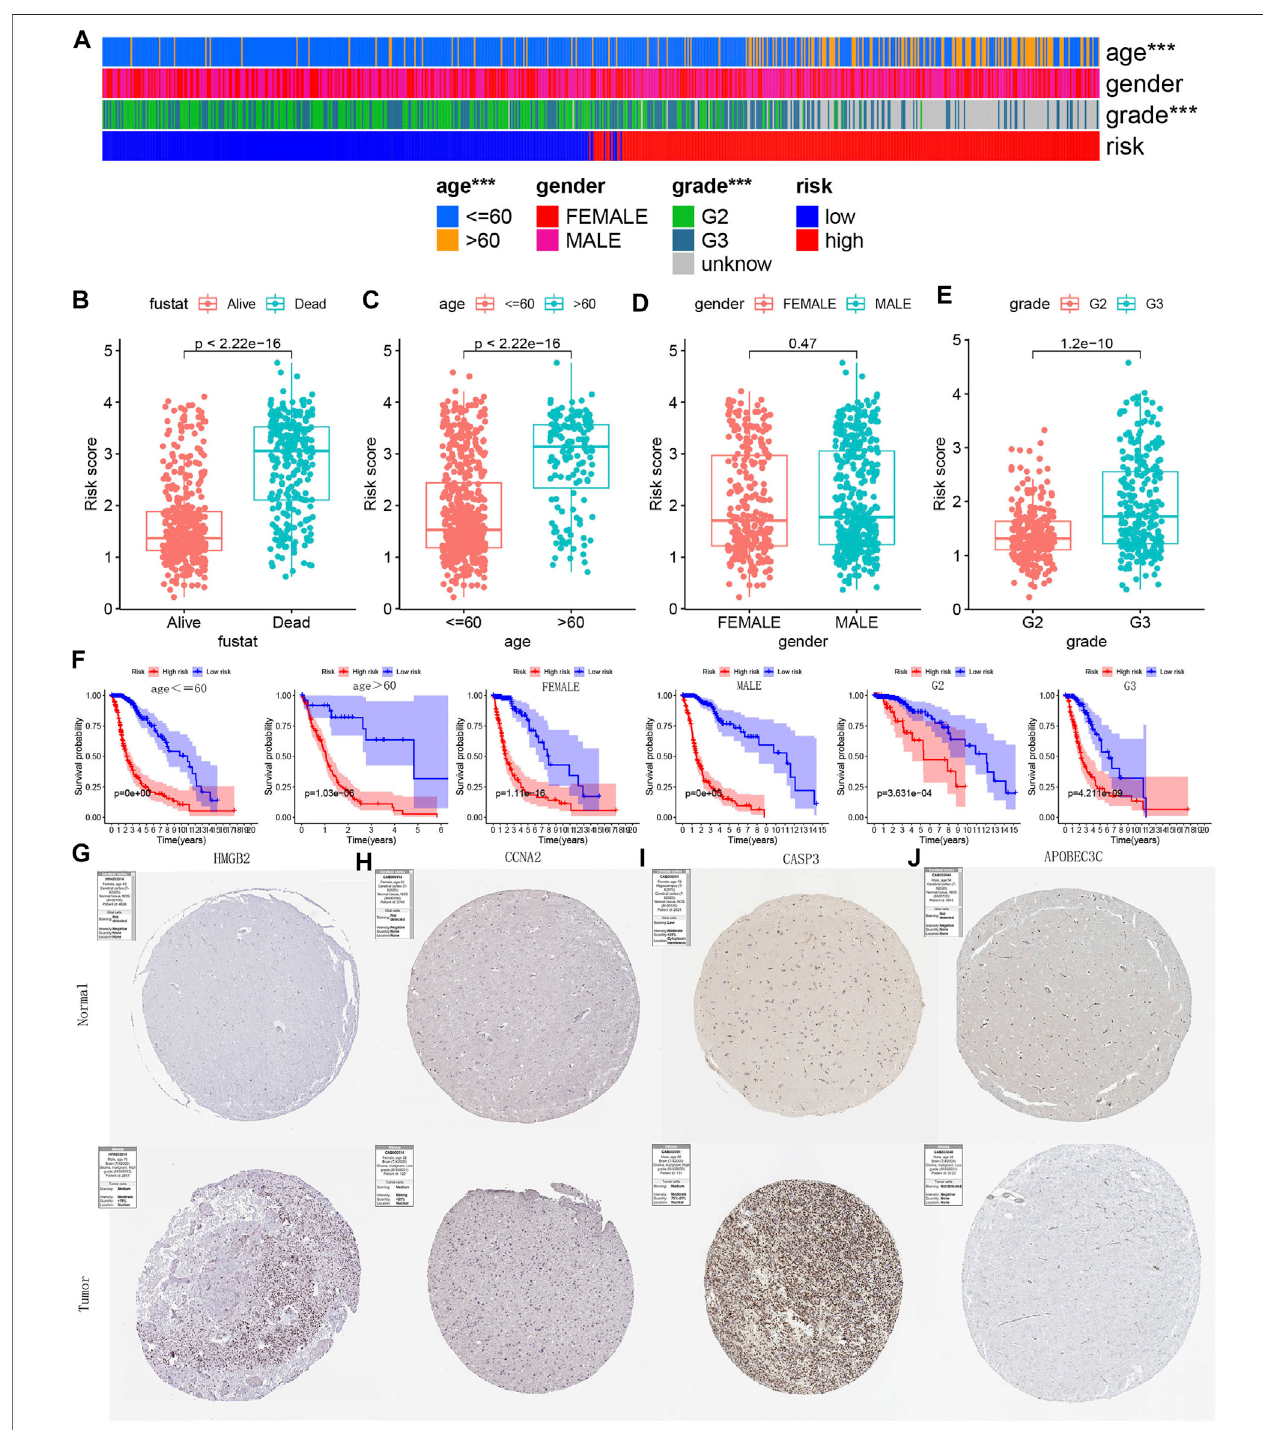
FIGURE 15 | Clinical strati fi cation analysis and IHC staining images veri fi cation. (A) Heatmap re fl ecting the clinical characteristics of each sample in TCGA. no asterisk: no signi fi cance; *** p < 0.001. (B – E) Risk score difference of between different clinical subgroups. (F) Kaplan-Meier survival curves re fl ecting the model ’ s ability to discriminate prognosis in each clinical subgroup. (G – J) IHC staining images re fl ecting the protein expression levels of HMGB2, CCNA2, CASP3, and APOBEC3C in glioma and normal brain tissue.